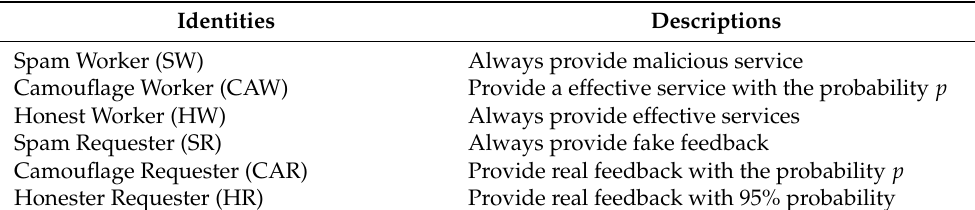
Table 2. Different identities of workers and